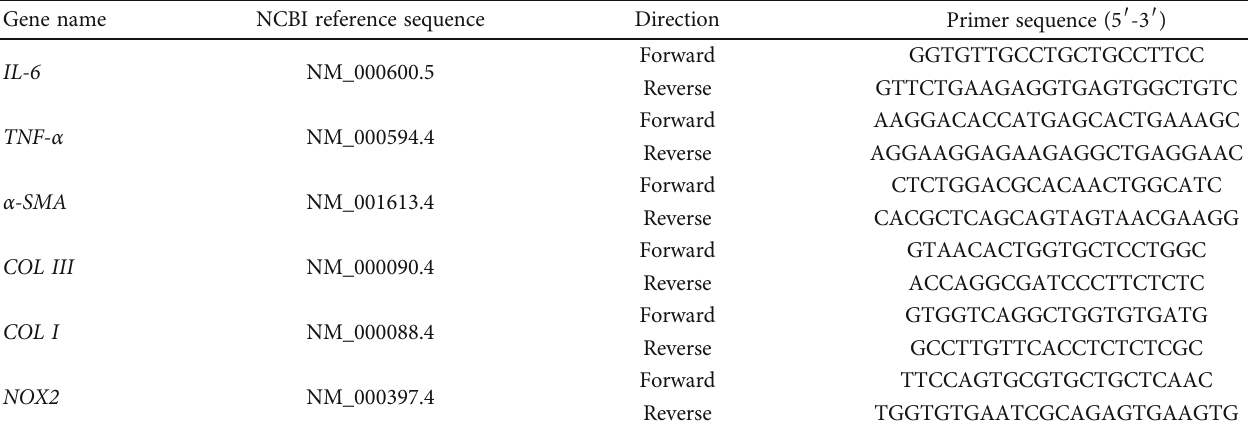
Table 1: Primers used for gene expression analysis by